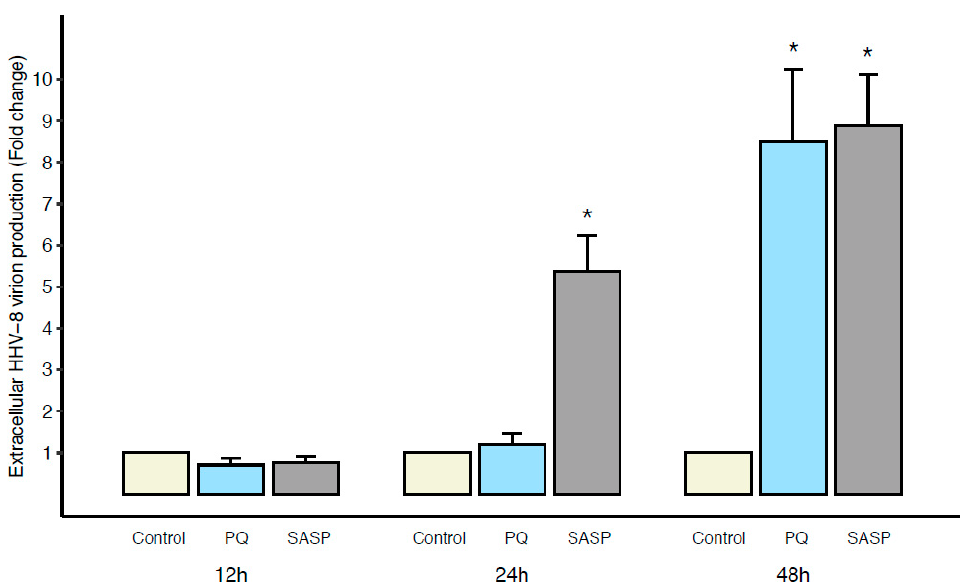
Figure 4. Extracellular HHV-8 virion production from PEL cells occurred after apoptosis induction by PQ. BC-3 cells were treated by PQ (10 µM) or SASP (0.25 mM as positive control) for 12 h, 24 h, or 48 h; then, extracellular HHV-8 virions were collected in the supernatant, as described in Materials and Methods . HHV-8 latency LANA DNA from each group was quantified by qPCR. The values of untreated control cells are defined as 1.0. Data are expressed as mean relative to their respective control at each individual time point (fold change). Error bars represent the S.E.M of triplicates for at least 2 independent experiments. *, p < 0.05 vs. untreated control (Wilcoxon–Mann–Whitney test).